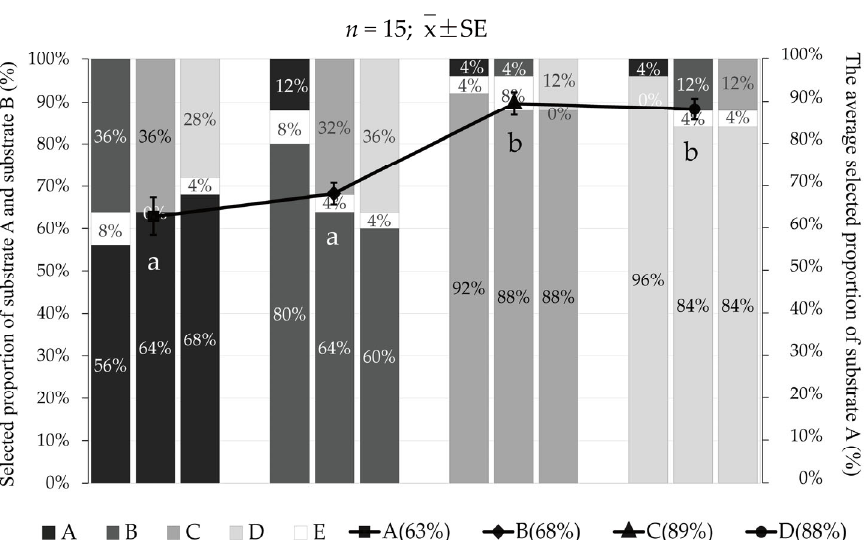
Figure 8. The preference of Meretrix meretrix for four grain size substrates: (A) coarse sand; (B) medium sand; (C) fine sand; (D) natural substrate; and (E) unselected. The bar graph shows the proportion selected of the different grain size substrates that were selected in twelve combinations. The line graph represents the average proportion of selection for the four grain size substrates. The different letters below the line graph indicate significant differences ( p < 0.05).